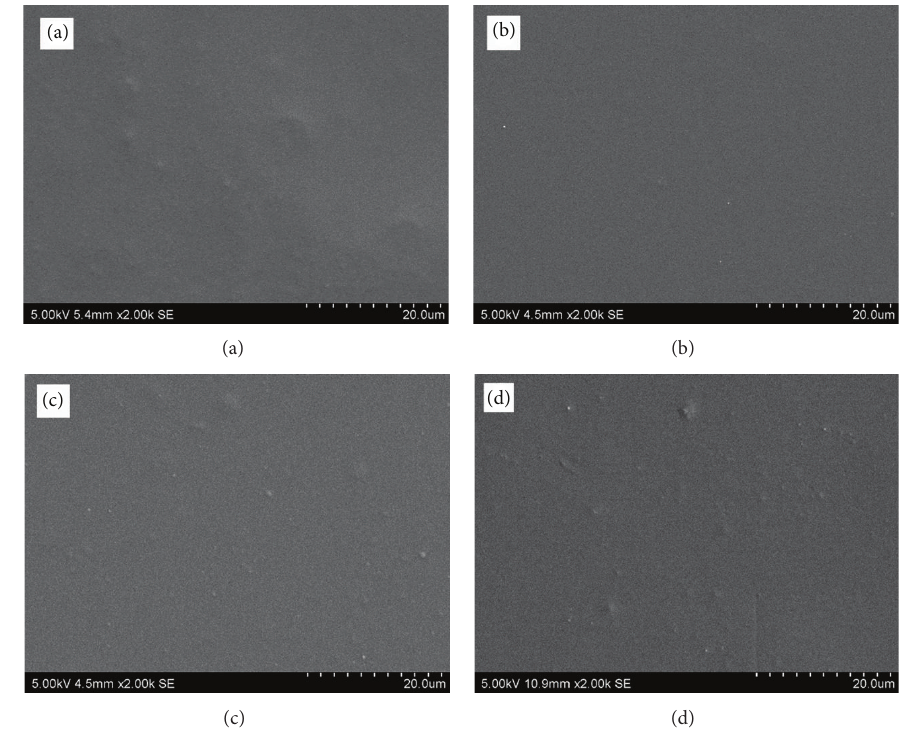
Figure 1: SEM images of regenerated films, (a) AmimCl, (b) BmimCl, (c) EmimCl, and (d) EmimAc. Table 1: Crystallinity, peak positions in X-ray diffractograms, and contact angle of cellulose films. Sample Crystallinity